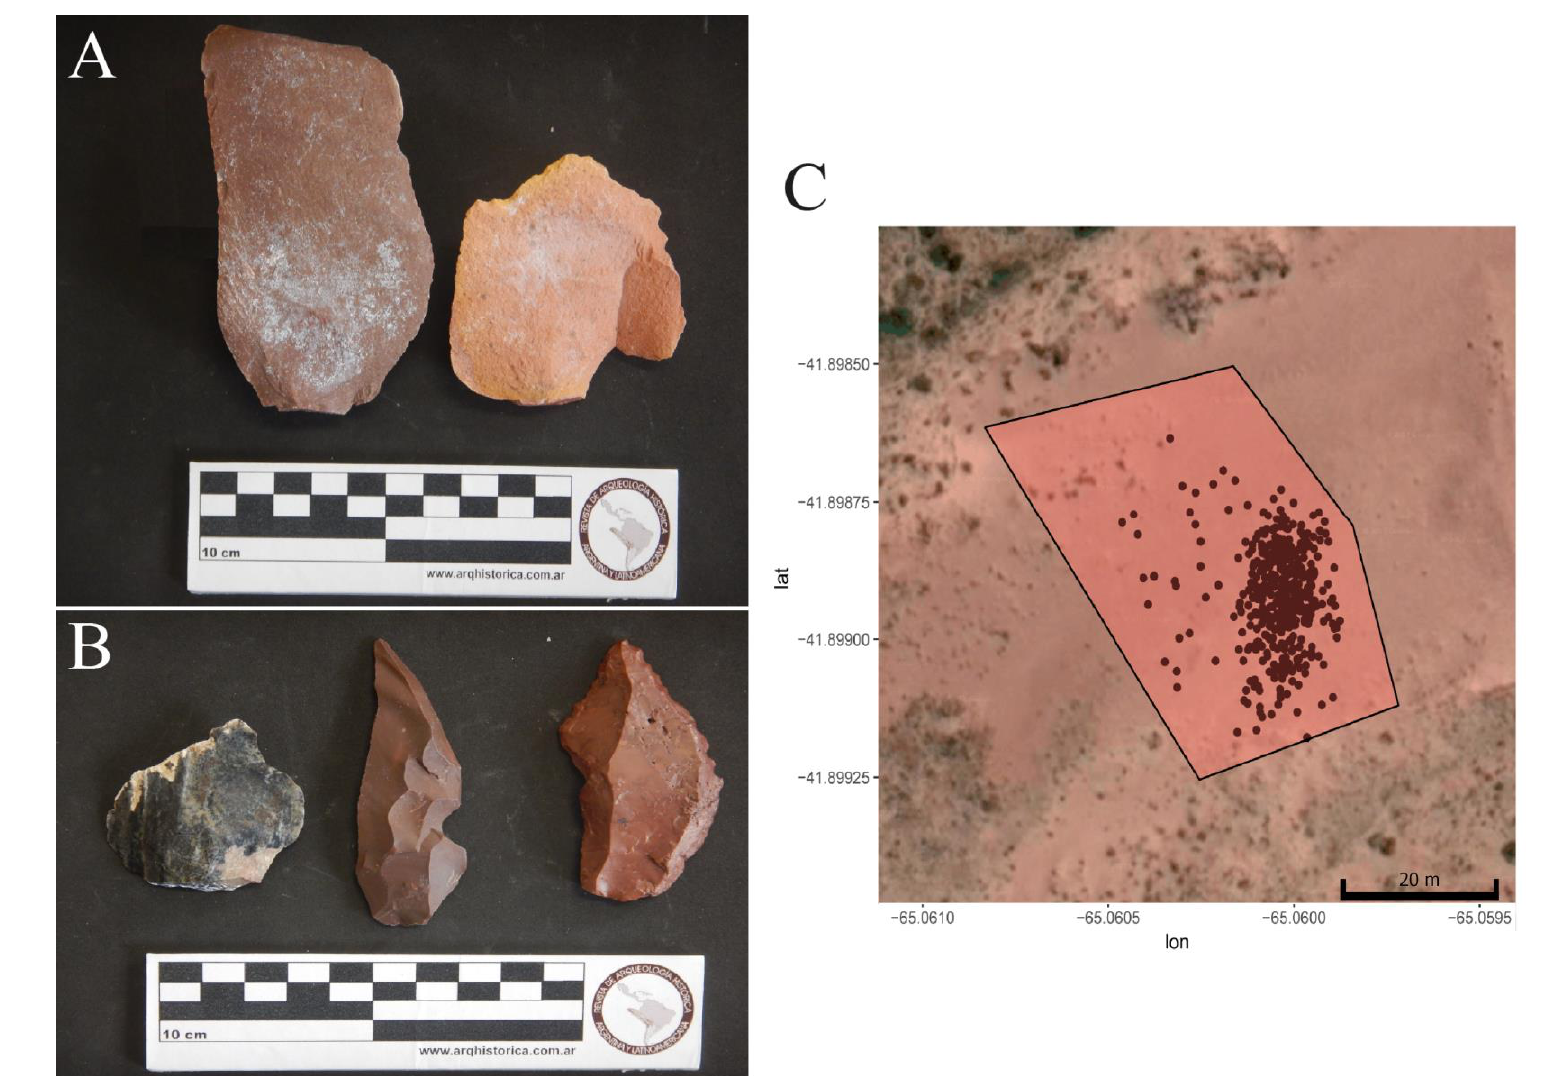
Figure 3. Artefacts collected with A) carbonate coating and B) soft corrasion surface. C) Sampling area and the distribution of specimens analysed